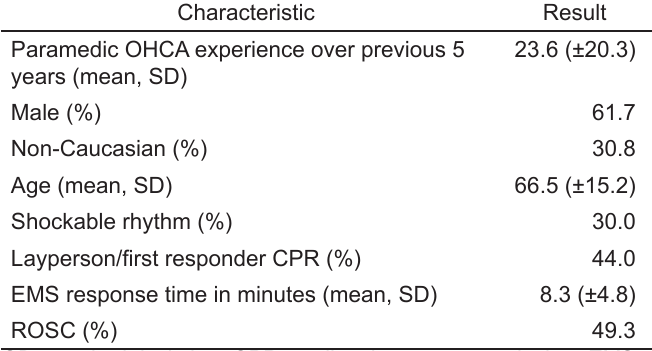
Table 1. Demographics of patients enrolled in a study of the effect of paramedic out-of-hospital cardiac arrest (OHCA) case volume on return of spontaneous circulation